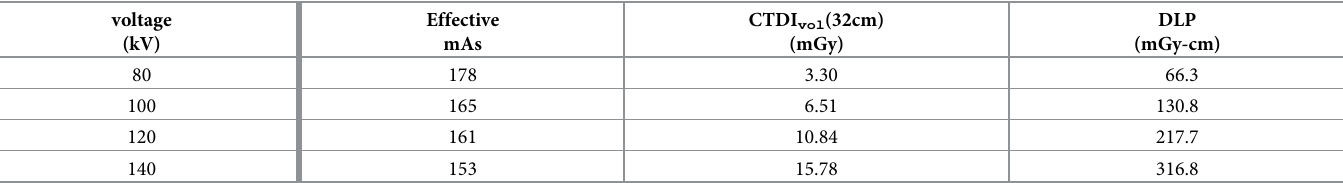
Table 1. Scan parameters with different